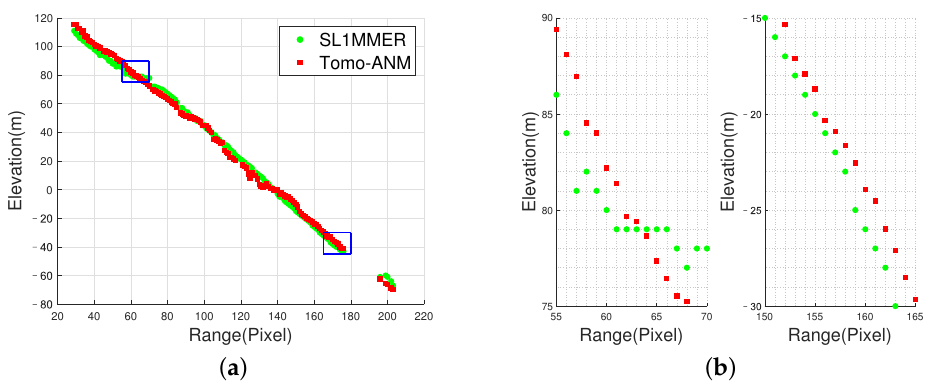
Figure 13. Tomographic profiles of a line target. ( a ) The Tomo-ANM and SL1MMER profiles of line azimuth 69. ( b ) Partial enlargement of the blue rectangle in ( a ).